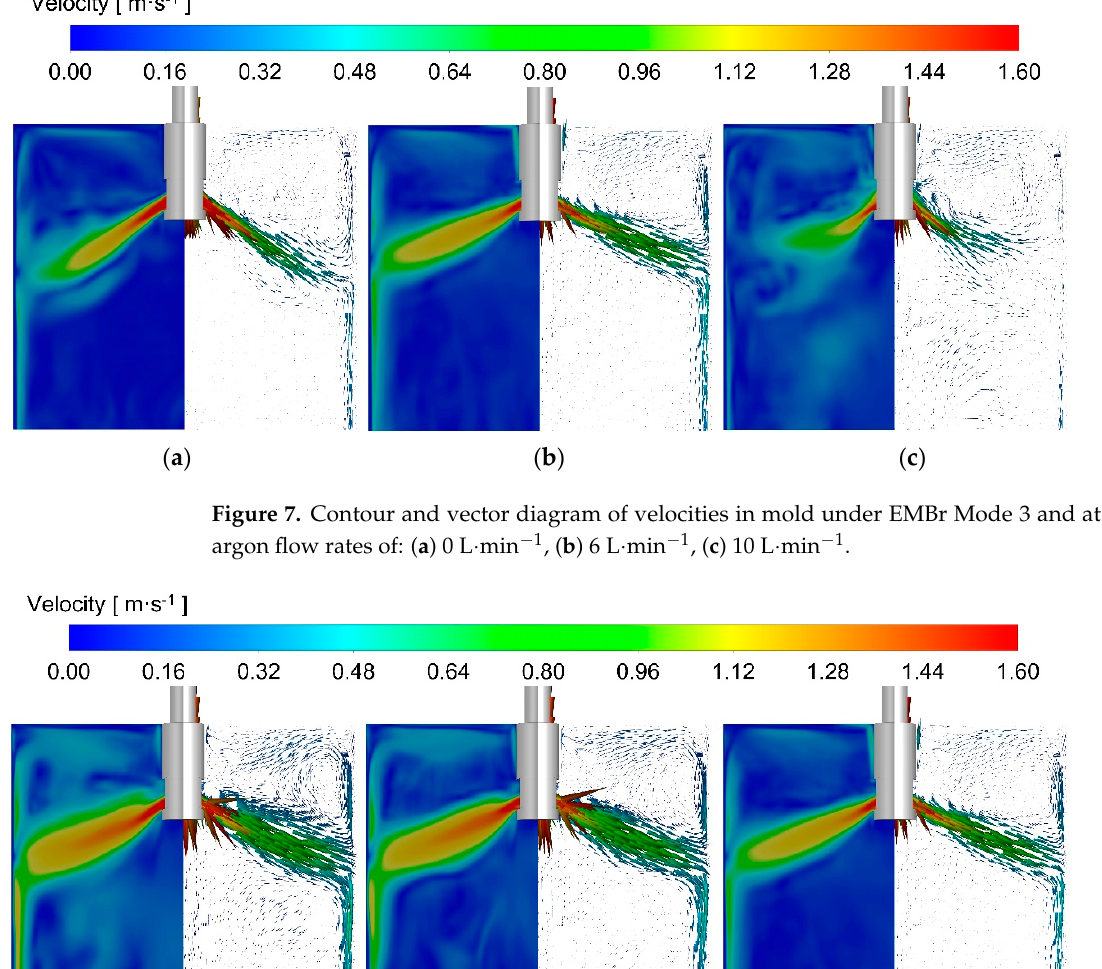
Figure 7. Contour and vector diagram of velocities in mold under EMBr Mode 3 and at different argon flow rates of: ( a ) 0 L·min − 1 , ( b ) 6 L·min − 1 , ( c ) 10 L·min − 1.